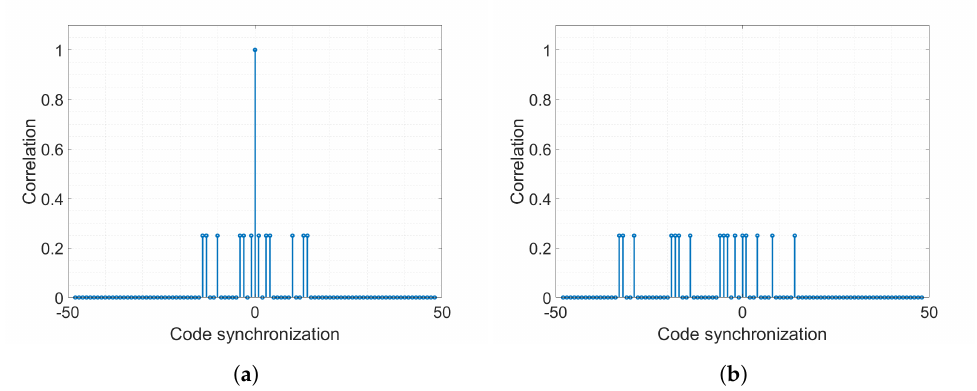
Figure 9. Auto- and cross-correlation properties of OOC. ( a ) OOC auto-correlation property. ( b ) OOC cross-correlation property.